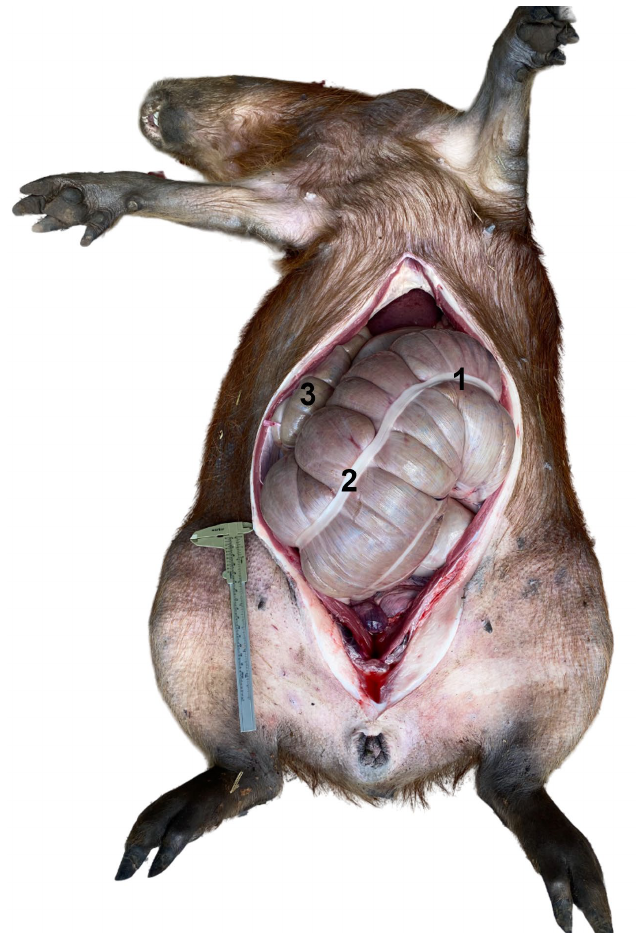
Figure 6. Capybara in dorsal recumbency. Ventral midline incision showing the extension of the cecum when tympanic. (1) Cecum left flexure, in syntopy with the left ovary; (2) cecum body; (3) cecum apex.